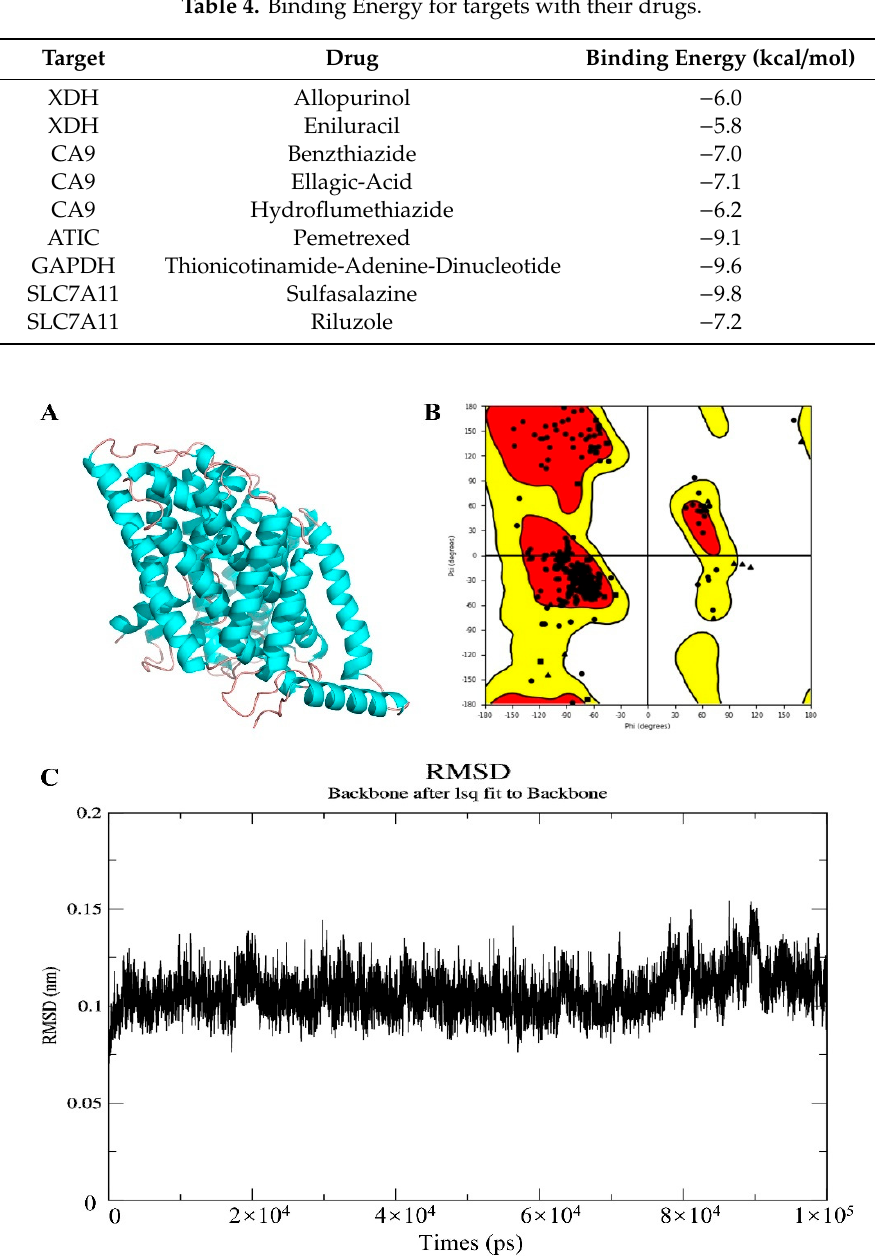
Figure 9. Homologous modeling of SLC7A11 protein structure. ( A ) 3D structure of SLC7A11. ( B ) Ramachandran plot analysis. ( C ) The root-mean-square deviation (RMSD) profile for time period of 100 ns.